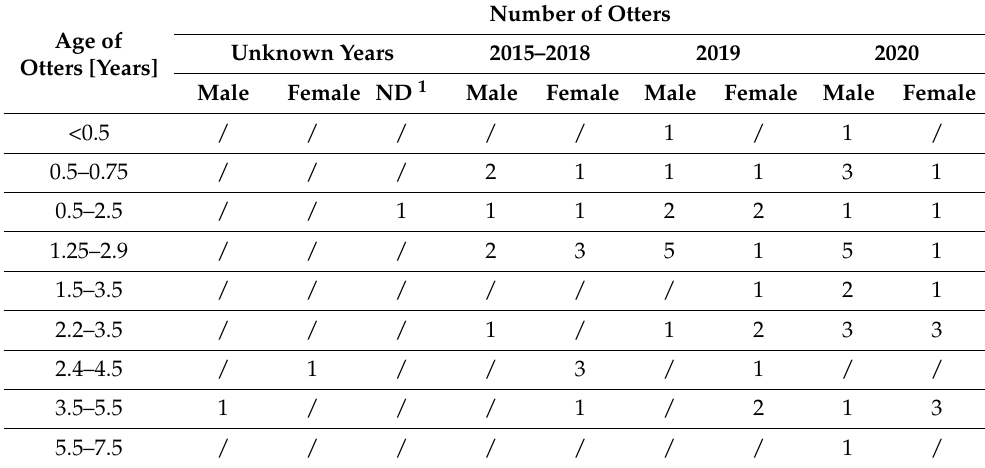
Table 1. Results of cementum aging of 65 otters found dead in Schleswig-Holstein.